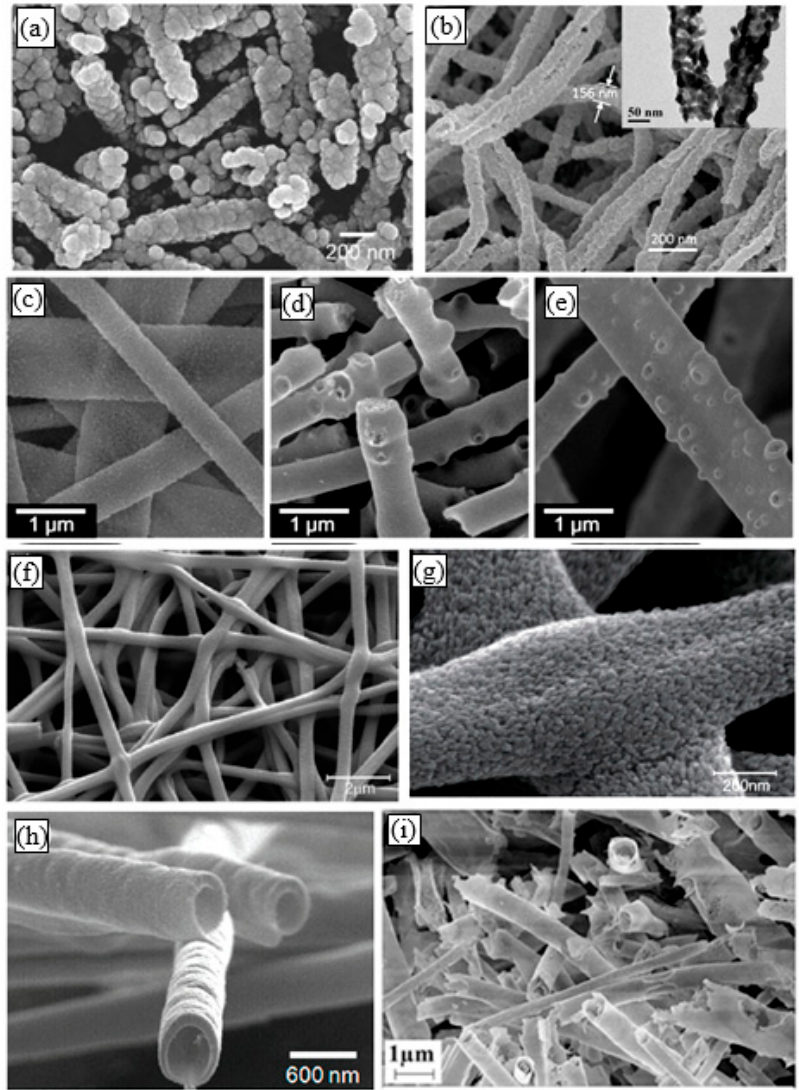
Figure 1. Typical SEM images of electrospun metal oxide nanofibers (NFs): ( a ) SnO 2 NFs, ( b ) In 2 O 3 NFs; ( c – e ) WO 3 NFs with different porosity ( T cal = 200–500 °C); ( f , g ) TiO 2 NFs; ( h ) Hollow ZnO NFs ( T cal = 500 °C); ( i ) Hollow Fe 2 O 3 NFs ( T cal = 650 °C). ( a ) Reprinted with permission from [25]. Copy- right 2010 Elsevier; ( f , g ) Reprinted with permission from [26]. Copyright 2013 RSC; ( h ) Reprinted with permission from [27]. Copyright 2009 ACS; ( i ) Reprinted with the permission from [28]. Copy- right 2019 Elsevier; ( b ) Reprinted from [29]; ( c – e ) Reprinted from [30].